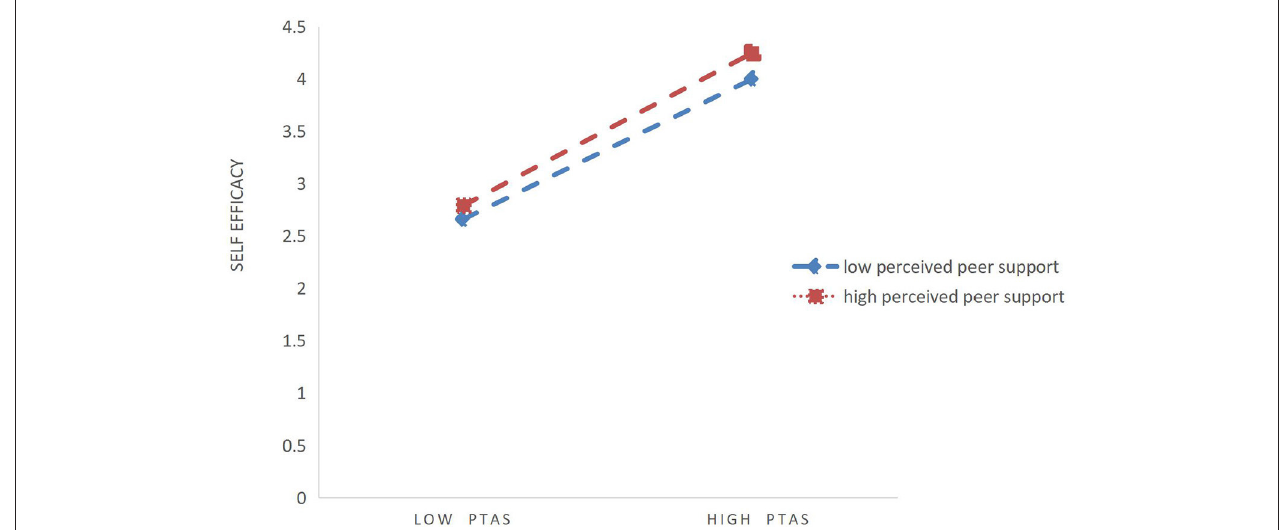
FIGURE 2 | Interaction effect of perceived peer support and perceived teacher autonomy support on the self-efficacy. High and low levels of perceived support represent one standard deviation above and below the mean.